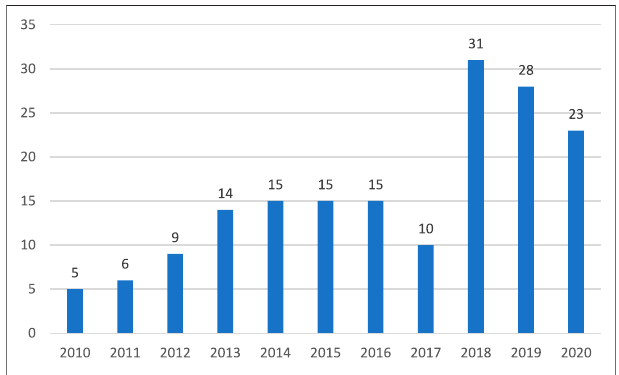
FIGURE 3 | Evolution of AS